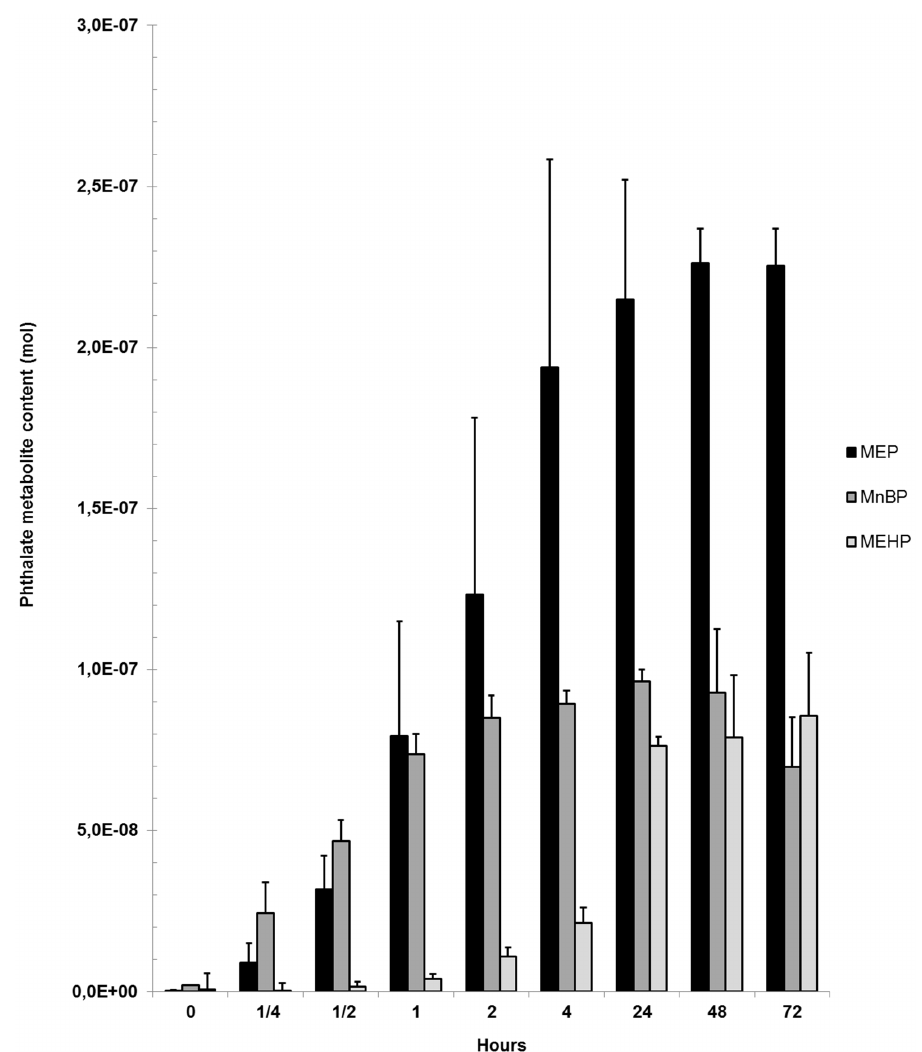
Fig 2. Time study of phthalate diester metabolism. The measured content of MEP, MnBP and MEHP are expressed as mean ± SD at time points 0 to 72 hours after phthalate diester addition (0.1 μ M DEP, DnBP or DEHP) to TSH-stimulated cell cultures (n = three cultures in single determination). The monoester concentrations are corrected for background contamination. MEP: mono-ethyl phthalate. MnBP: mono-n- butyl phthalate. MEHP: mono-2-ethylhexyl